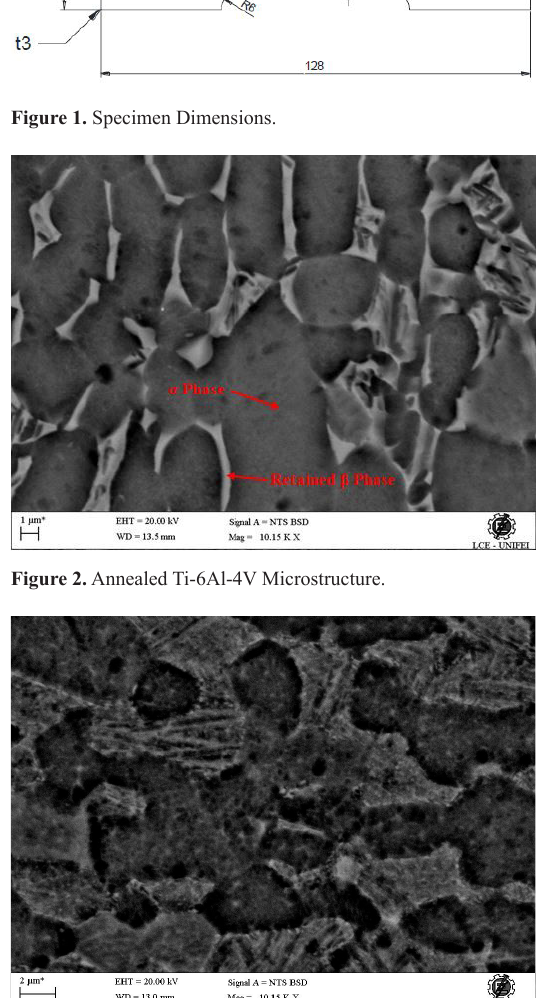
Figure 3. SA Ti-6Al-4V